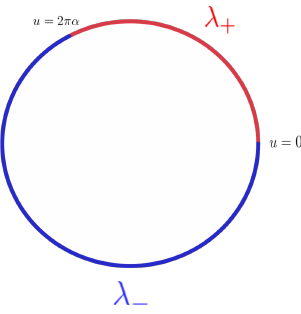
Figure 1 . The background field profile λ ( u ) for the marginal operator which appears in the path integral. The source jumps discontinuously at u = 0 and u = 2 πα